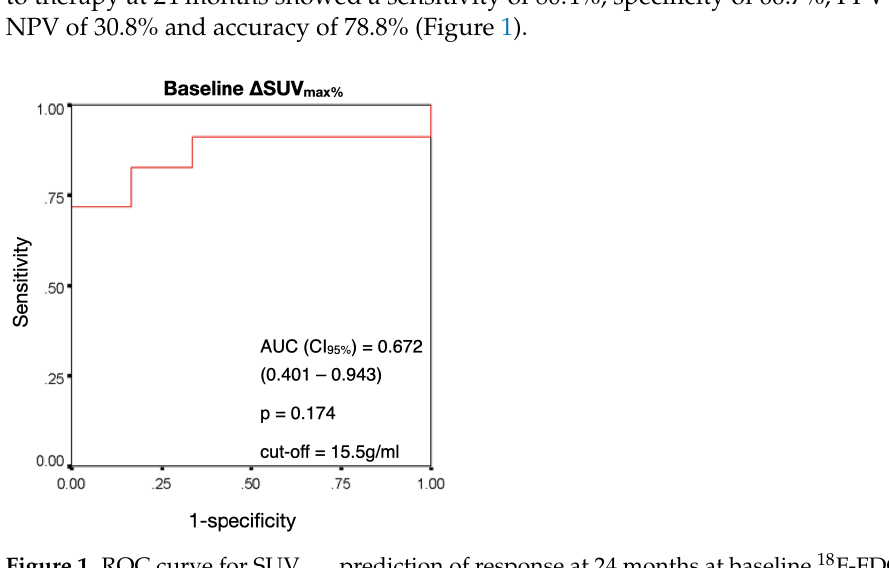
Figure 1. ROC curve for SUV max prediction of response at 24 months at baseline 18 F-FDG PET-CT. AUC = area under the ROC curve. CI 95% = 95% confidence interval.